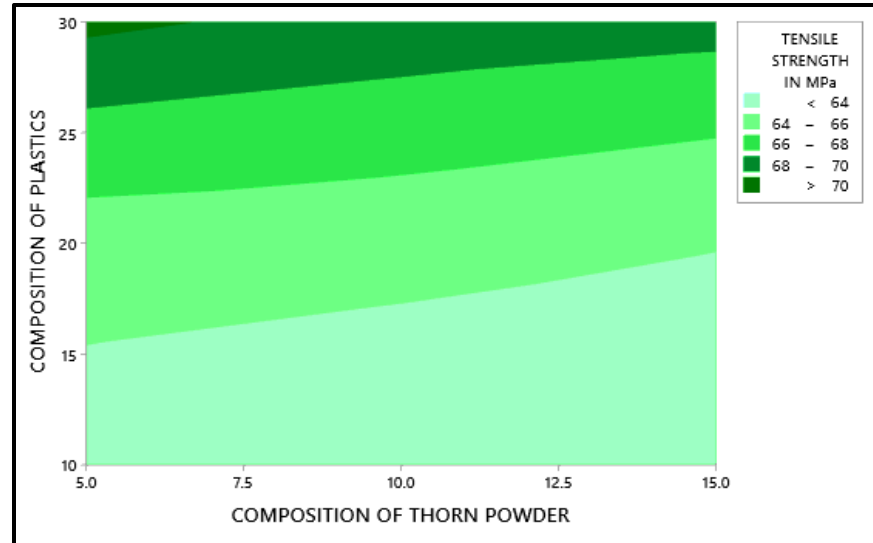
Figure 12. Tensile strength results through contour graph.